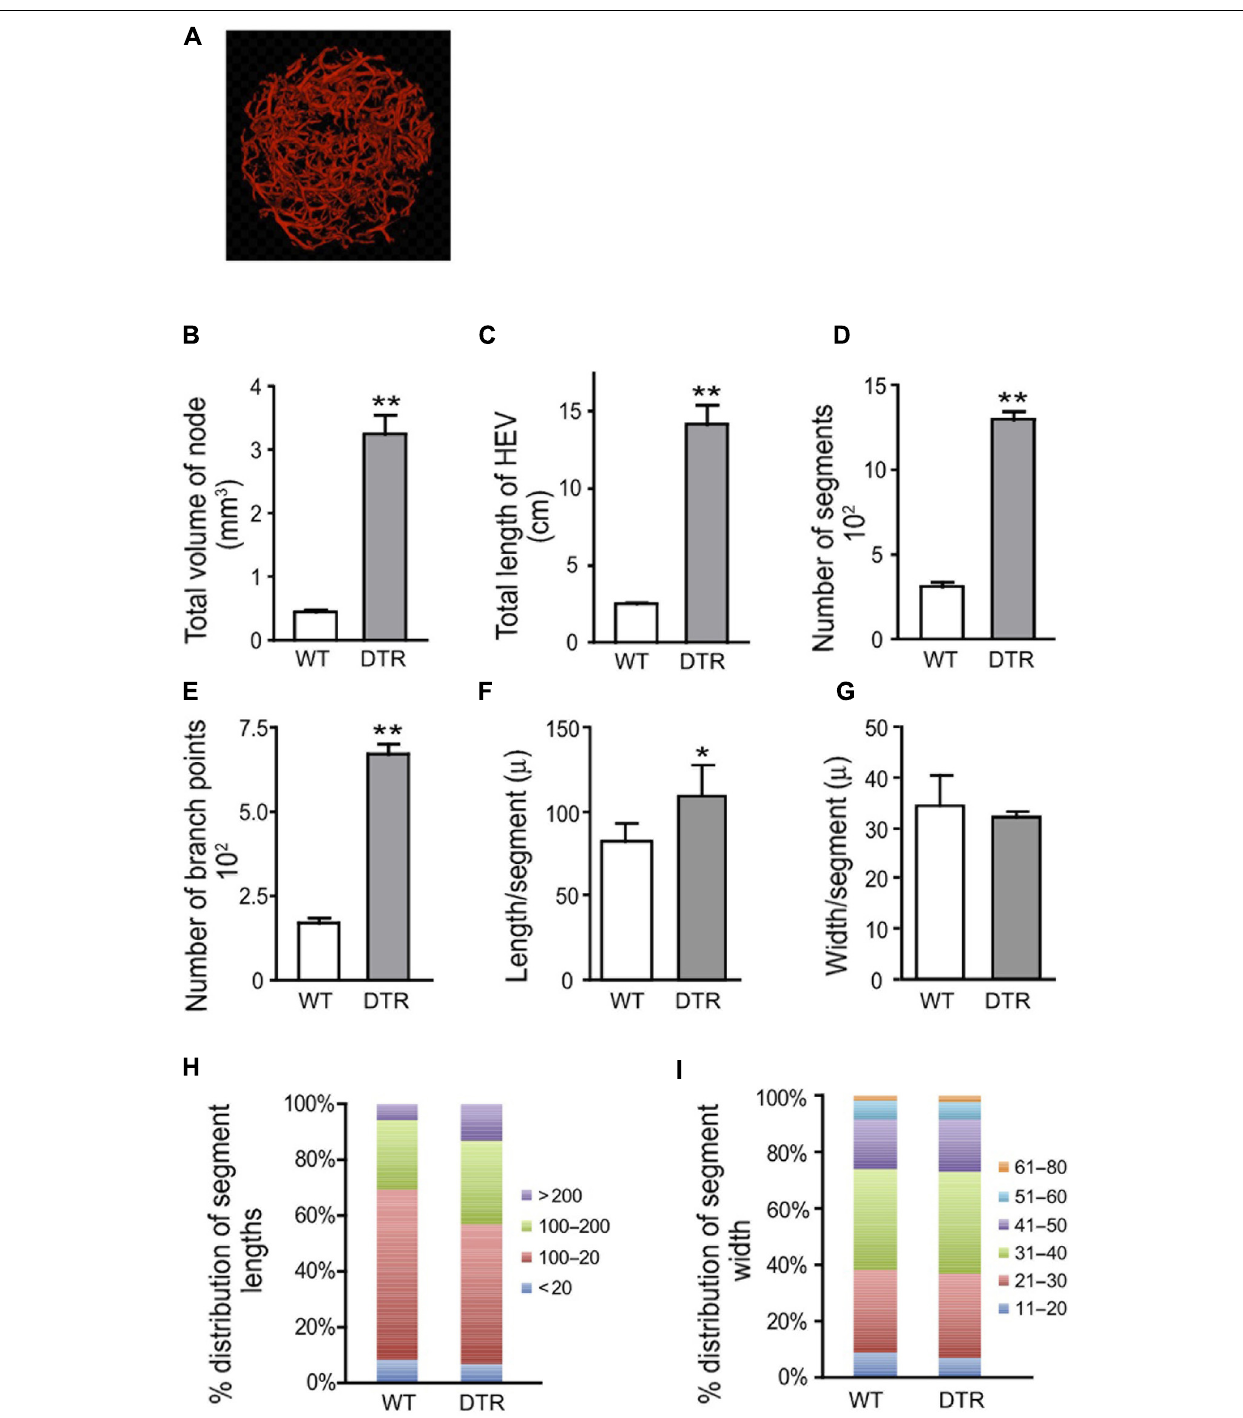
FIGURE 2 | High endothelial venule (HEV) growth in Foxp3-DTR mice is similar to that induced by OVA/CFA immunization. Wild-type (WT) and Foxp3-DTR (DTR) mice were injected with DT to deplete regulatoryT cells as per Section “Materials and Methods” and popliteal lymph nodes were prepared for OPT imaging of PNAd + vessels. (A) Representative image of Foxp3-DTR lymph node from OPT scanning. Scale is same as that of Figure 1A to allow comparisons to nodes stimulated with OVA/CFA. (B) Total lymph node volume. (C) Total length of HEV per lymph node. (D) Number of HEV